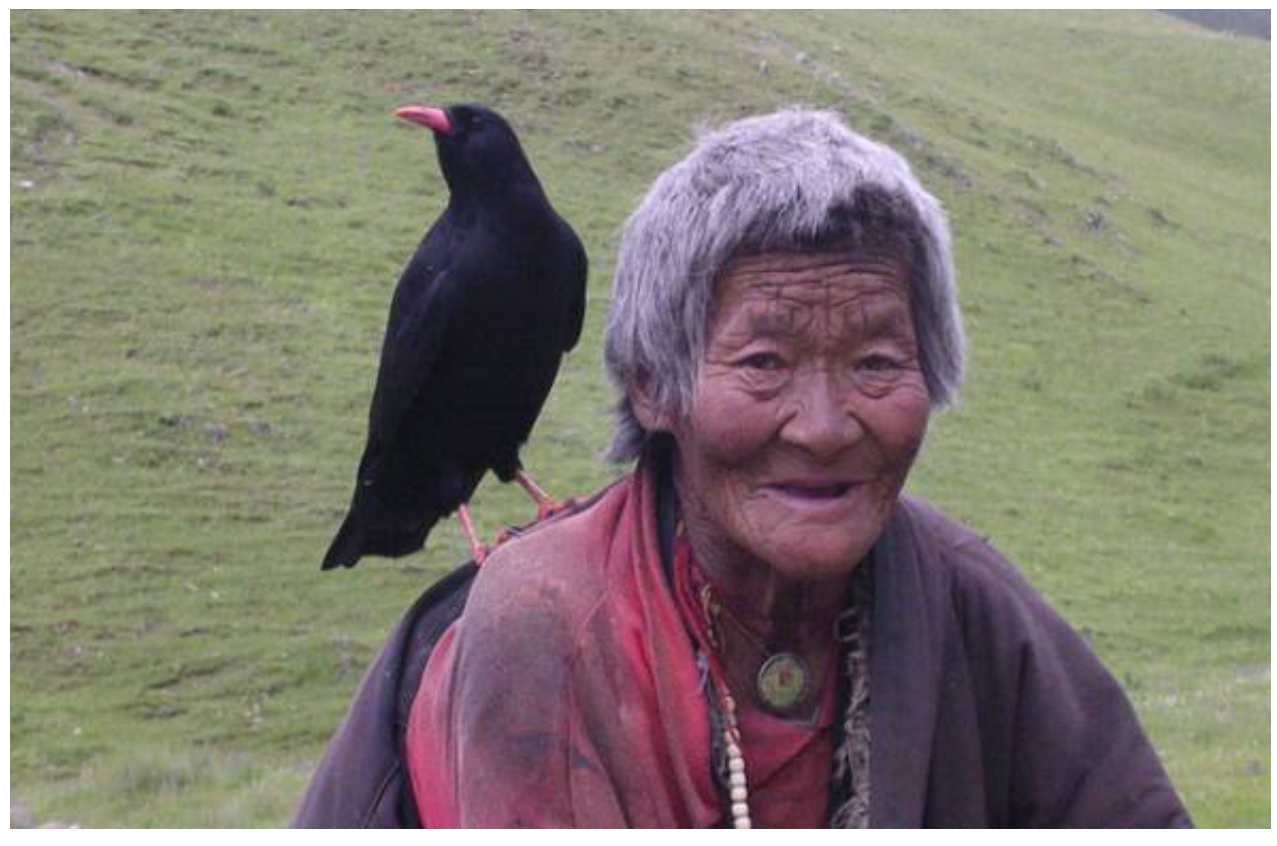
Fig. 4. A chough sits on a Tibetan widow’s shoulder. The local people believe that the bird is the reincarnation of the woman’s daughter. [